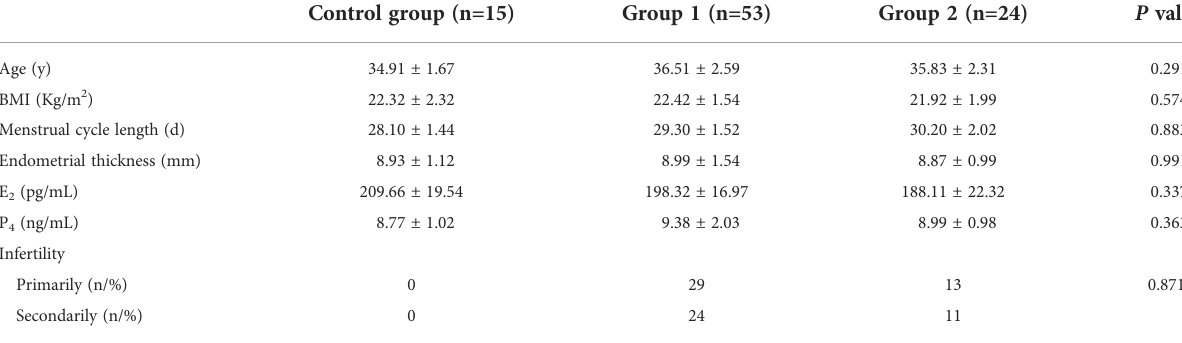
Table 1. The study group exhibited relatively high homogeneity. TABLE 1 Demographic characteristics in women with CE or fertile